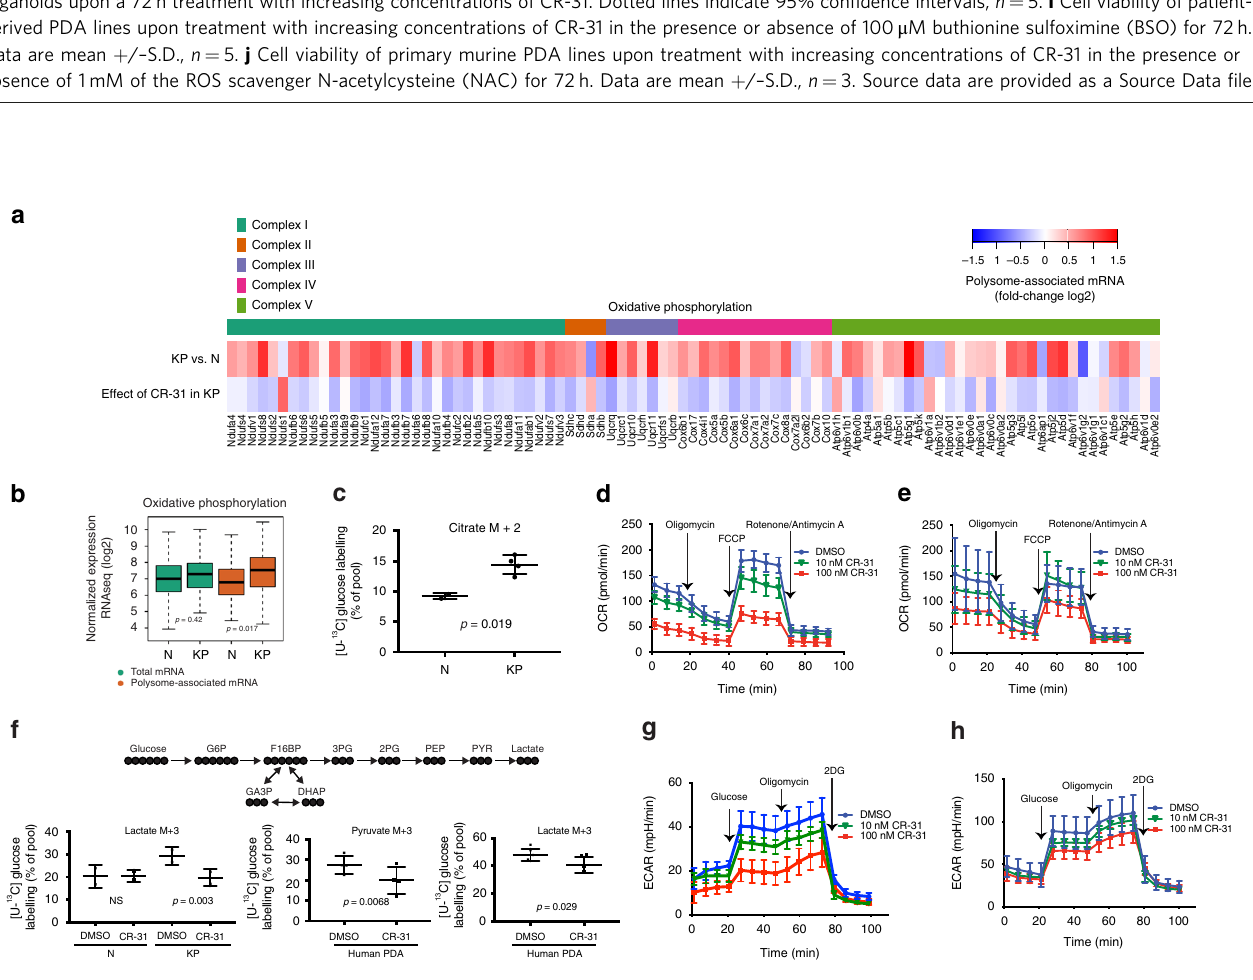
Fig. 4 CR-31 translationally targets oxidative phosphorylation and glycolysis in PDA. a Heatmap of oxidative phosphorylation pathway proteins showing fold-changes of polysome-associated mRNA. b Boxplots of total and polysome-associated mRNA levels for transcripts encoding oxidative phosphorylation components. Horizontal line indicates the median; lower and upper box indicate the fi rst and third quartiles. Whiskers extend from the box to the most extreme value but not further than + / − 1.5 * inter-quartile range (IQR) from the box. Data exceeding the whiskers are plotted as points. b 13 C 6 -glucose tracing of N ( n = 2) and KP organoids ( n = 4). M + 2 labelled citrate is derived directly from 13 C 6 -glucose. Data are mean + / – S.D., Student ’ s t -test. c Mitochondrial respiration re fl ected by oxygen consumption rate (OCR) was measured in KP organoids treated with vehicle or CR-31 for 5 h and following the addition of Oligomycin (1 μ M), the uncoupler FCCP (0.5 μ M), and the electron transport inhibitor Rotenone/Antimycin A (0.5 μ M). Data are mean + / – S.D, n = 3. Data are representative from three biological replicates. d OCR was measured in N organoids treated with vehicle CR-31 for 5 h and following the addition of Oligomycin, FCCP, and Rotenone/Antimycin A. Data are mean + / – S.D. n = 5. Data are representative from three biological replicates. e Top, fl ow of heavy carbons through the glycolytic pathway. Bottom, 13 C 6 -glucose tracing of two sets of N and KP organoids (left) and 4 patient-derived PDA cell lines (middle and right) upon treatment with vehicle or 100 nM CR-31 for 5 h. Data are mean + / – S.D., Student ’ s paired t -test. f Glycolysis re fl ected by extracellular acidi fi cation rate (ECAR) was measured in KP organoids treated with vehicle or CR-31 for 5 h and following addition of glucose (10 mM), Oligomycin (1 μ M), and the glucose analog, 2-deoxyglucose, 2DG (50 mM). Data are mean + / – S.D., n = 3. Data are representative of three biological replicates. g ECAR was measured in N organoids treated with vehicle or CR-31 for 5 h and following addition of glucose, Oligomycin, and 2DG. Data are mean + / – S.D., n = 5. Data are representative of three biological replicates. Source data are provided as a Source Data fi le